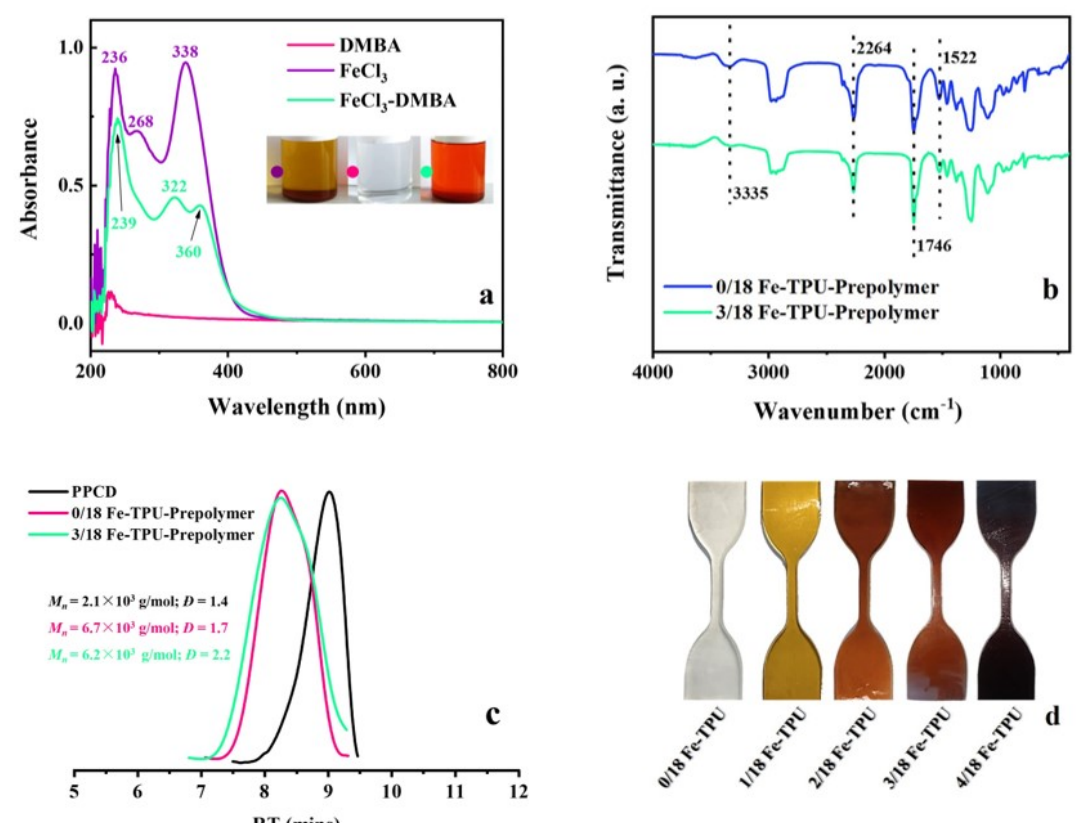
Figure 5. ( a ) UV − Vis spectra of DMBA, FeCl 3 , and FeCl 3 − DMBA; ( b ) FT − IR spectra of the prepolymer; ( c ) GPC curves of PPCD and the prepolymer; ( d ) physical pictures of TPU.